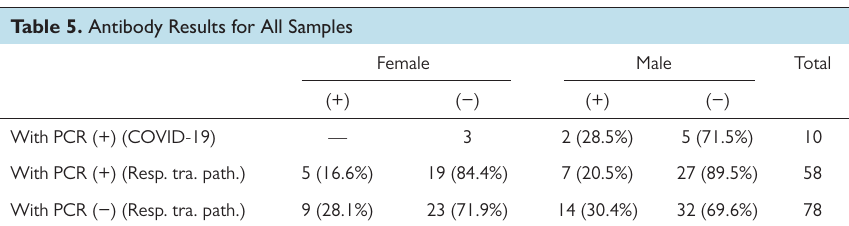
Table 5. Antibody Results for All